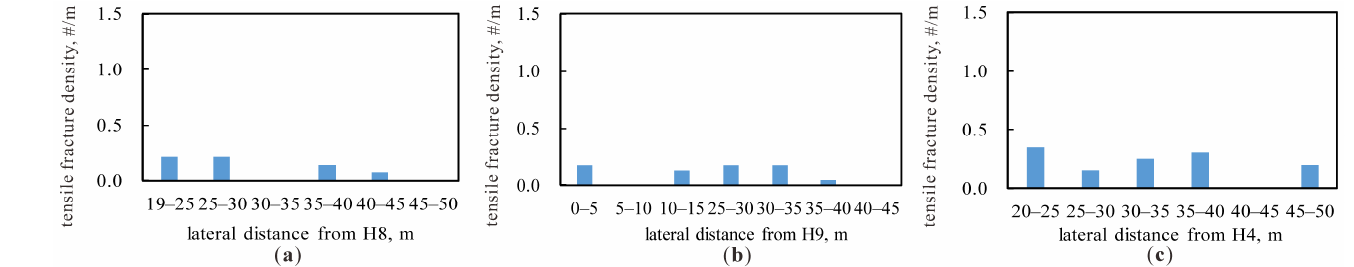
Figure 13. The distribution of tensile fracture density with respect to the lateral distance from adja- cent wells. ( a ) H8; ( b ) H9; ( c ) H4. wells. ( a ) H8; ( b ) H9; ( c )